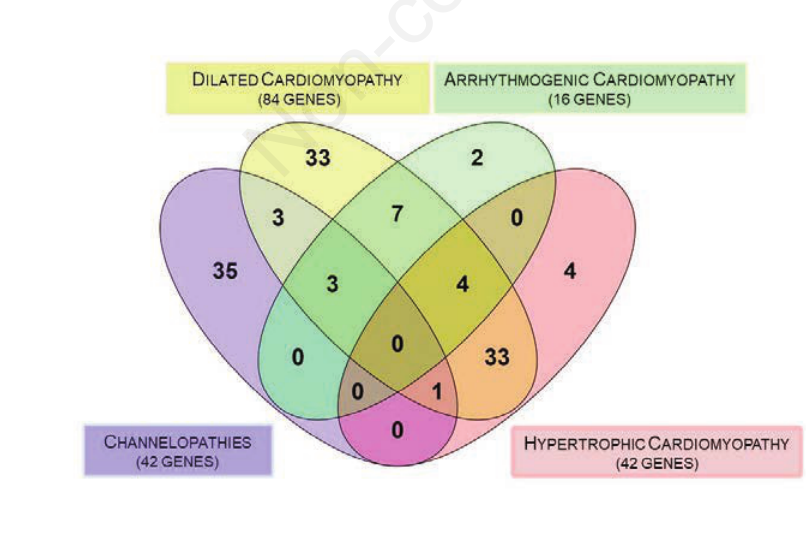
Figure 1. Schematic representation of cardiomyopathies and genes involved in Sudden Cardiac Death, can reflect our work and be used as a cover image. Diagram shows the overlap between the genes associated with Channelopathies, Dilated Cardiomyopathy (DCM), Hypertrophic Cardiomyopathy (HCM), Arrhythmogenic Cardiomyopathy